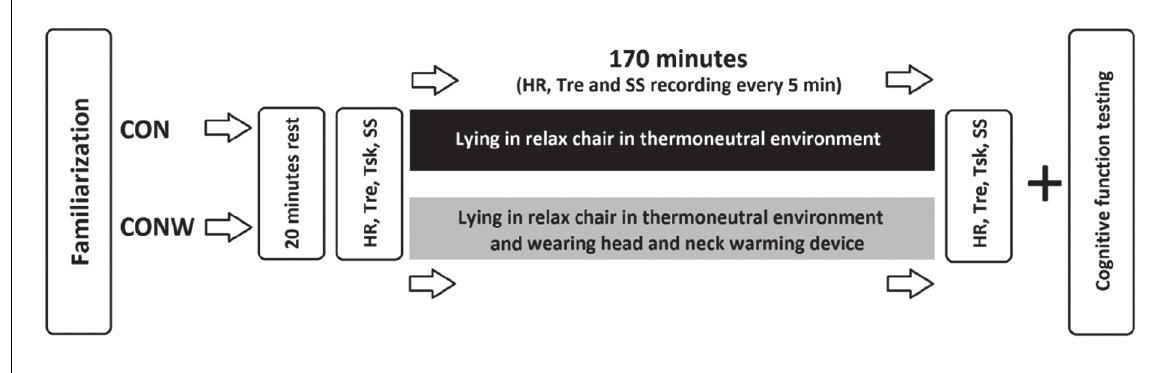
Figure 1. Research